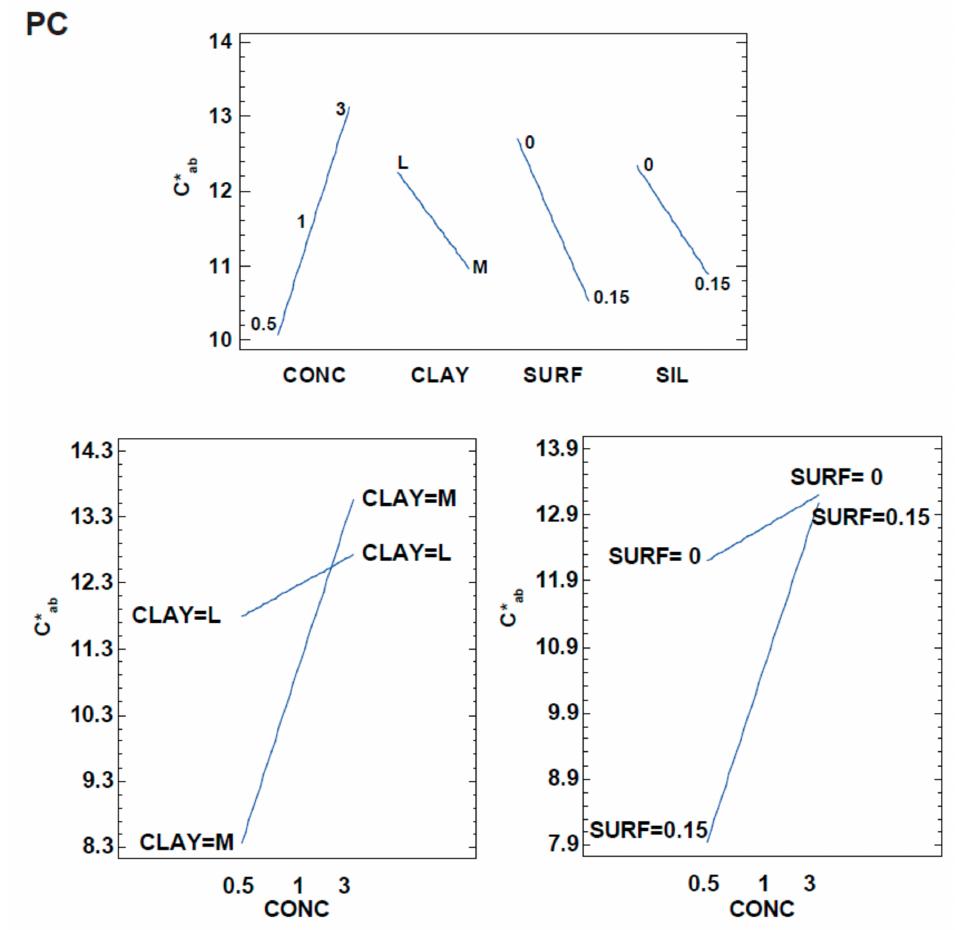
Figure 6. Main effects and interaction plots from the C ab * response in the PC